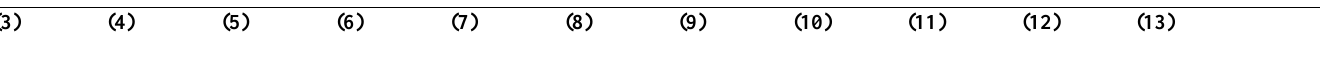
Table 3: Matrix of